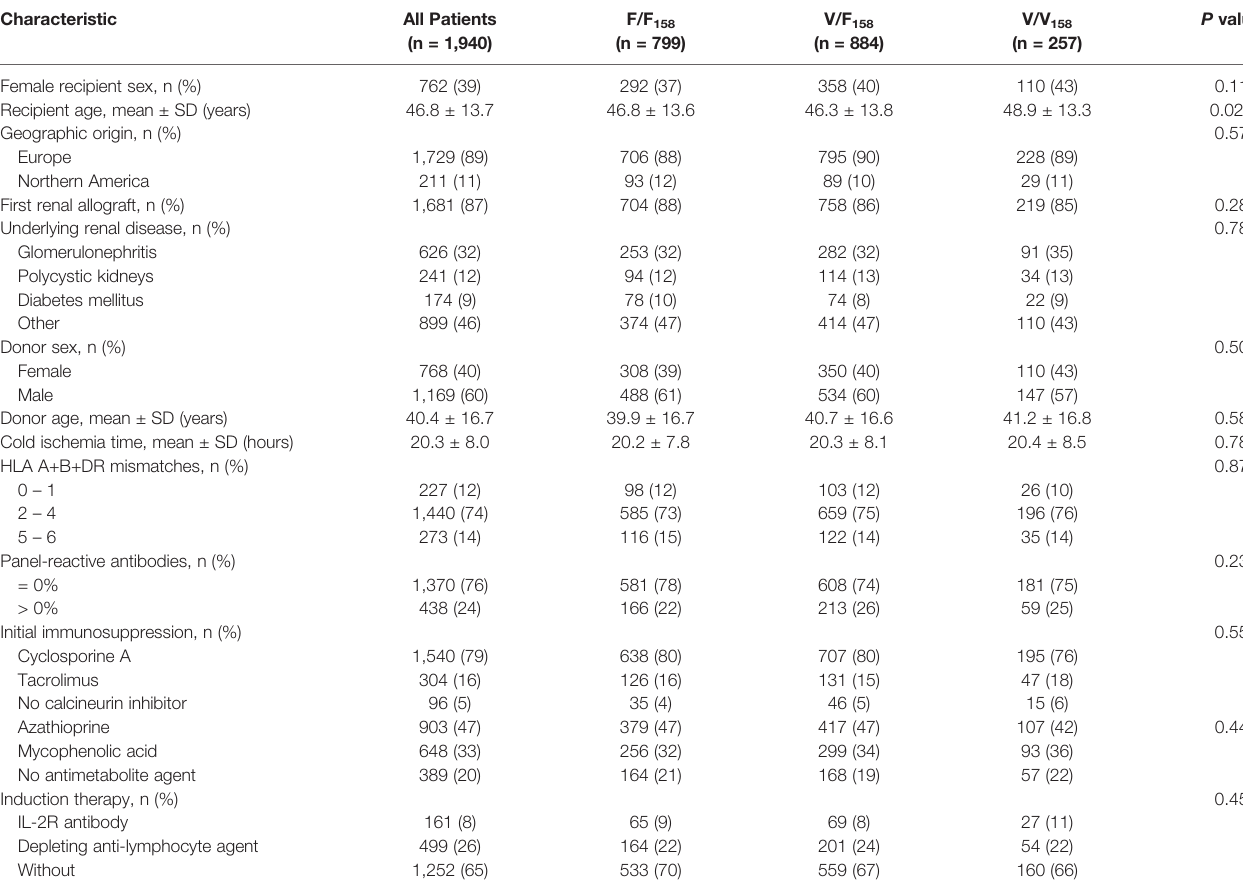
TABLE 1 | Patient baseline characteristics in relation to FCGR3A -V/F 158 genotype.